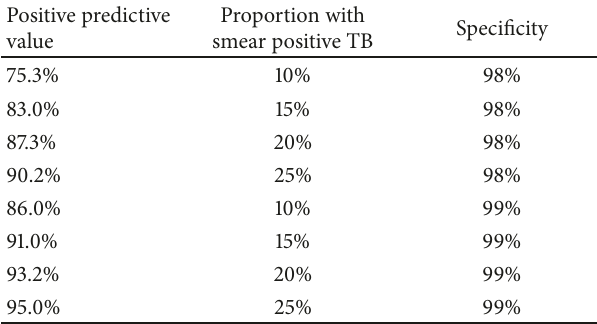
Table 2: Expected positive predictive values of smear microscopy assuming a sensitivity of 55% in the context of passive case